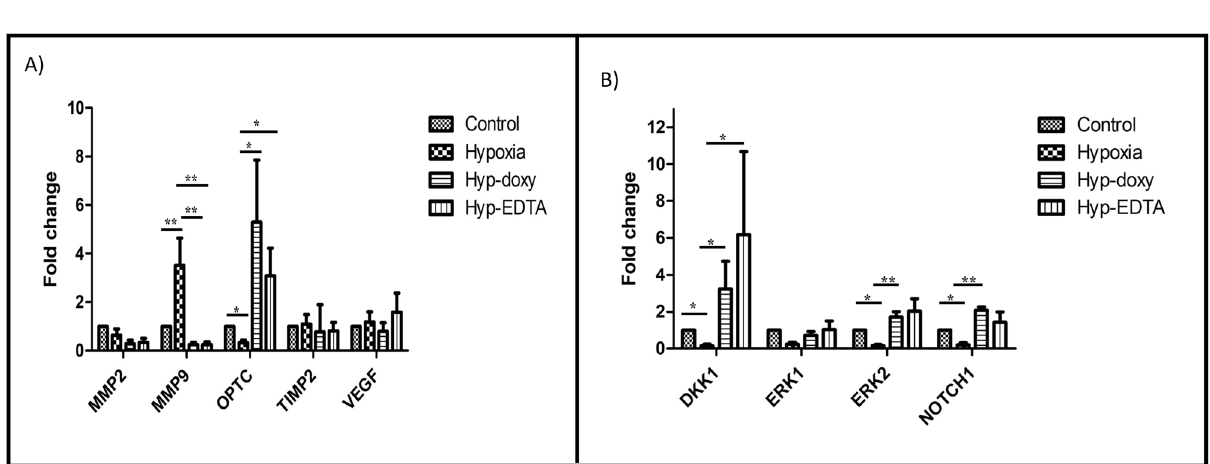
Figure 5. Differential gene expression of MMP2 , MMP9 , OPTC , VEGF and TIMP2 ( A ), and potential signalling pathway genes ( DKK1 , ERK1 , ERK2 , and NOTCH1 ) ( B ) in control, hypoxia (CoCl 2 ), hypoxia (CoCl 2 ) + doxycycline, and hypoxia (CoCl 2 ) + EDTA in microglial cells (n = 3), ** p = 0.001, * p = 0.05; data represented as mean ±